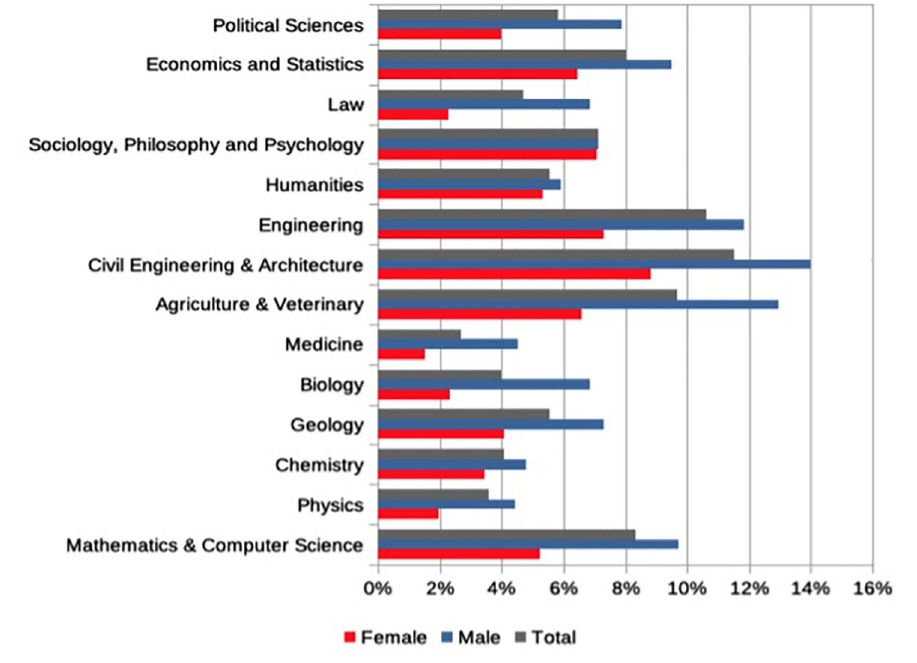
Fig 4. Start-up activity by scientific field and gender.